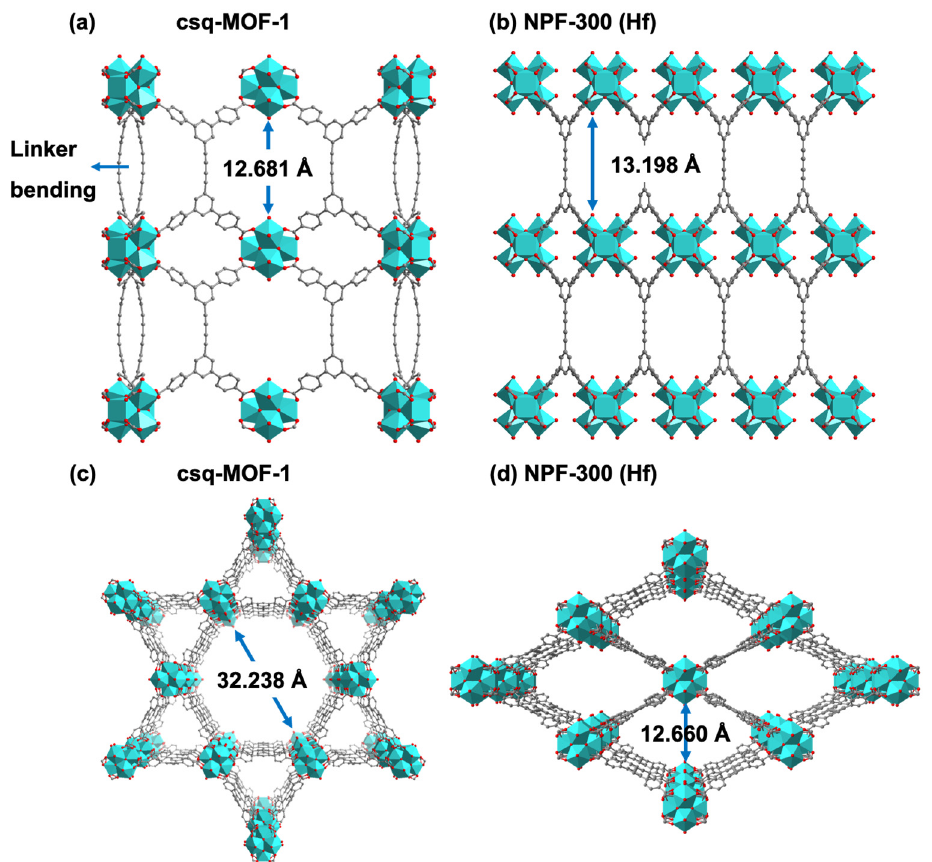
Figure 3. Structures viewed along the b axis and c axis. ( a ) Structure of csq-MOF-1, showing linker bending, cluster distance; ( b ) structure of NPF-300 (Hf), showing planar linker, cluster distance. ( c ) channel of csq-MOF-1; ( d ) channel of NPF-300 (Hf). Hf: cyan polyhedron; C: light gray; O: red; hydrogen atoms are omitted for clarity.